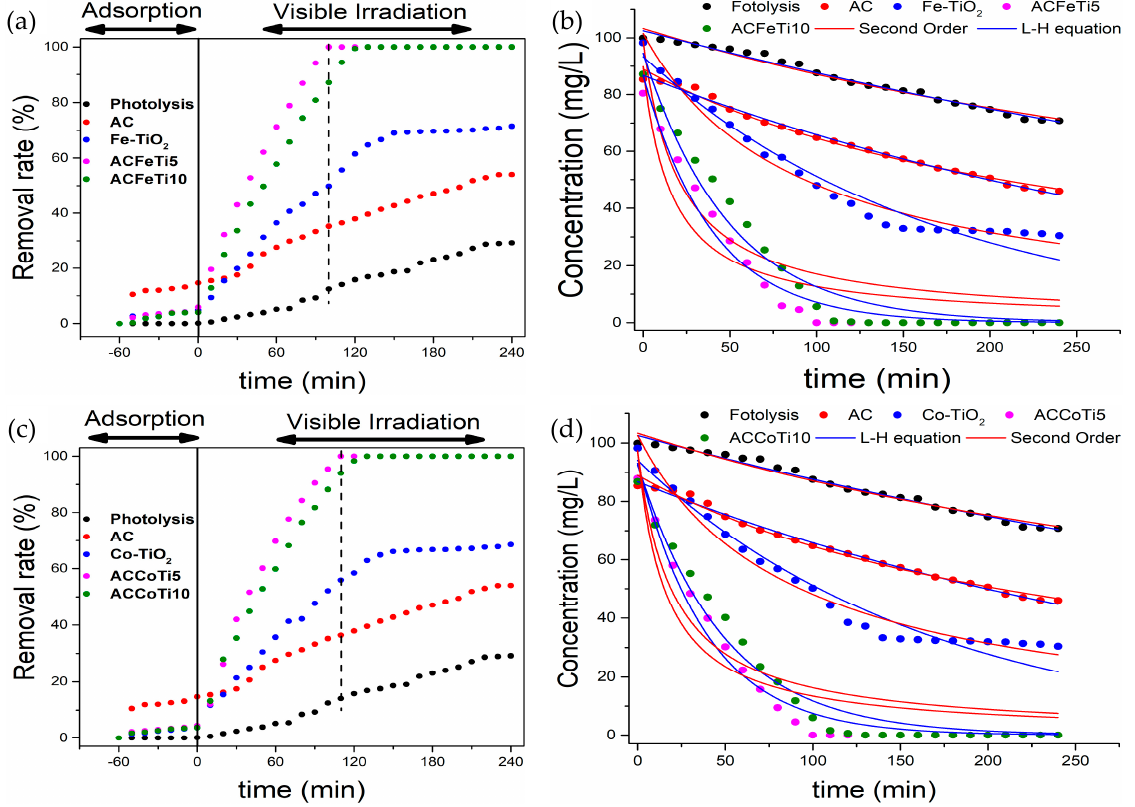
Figure 6. Removal rate and kinetics of photocatalytic degradation curves for CYF-4G dye in solution in presence of: ( a ) Co-TiO 2 /AC and ( c ) Fe-TiO 2 /AC. ( b ) Co-TiO 2 /AC and ( d ) Fe-TiO 2 /AC after irradiation with visible light.